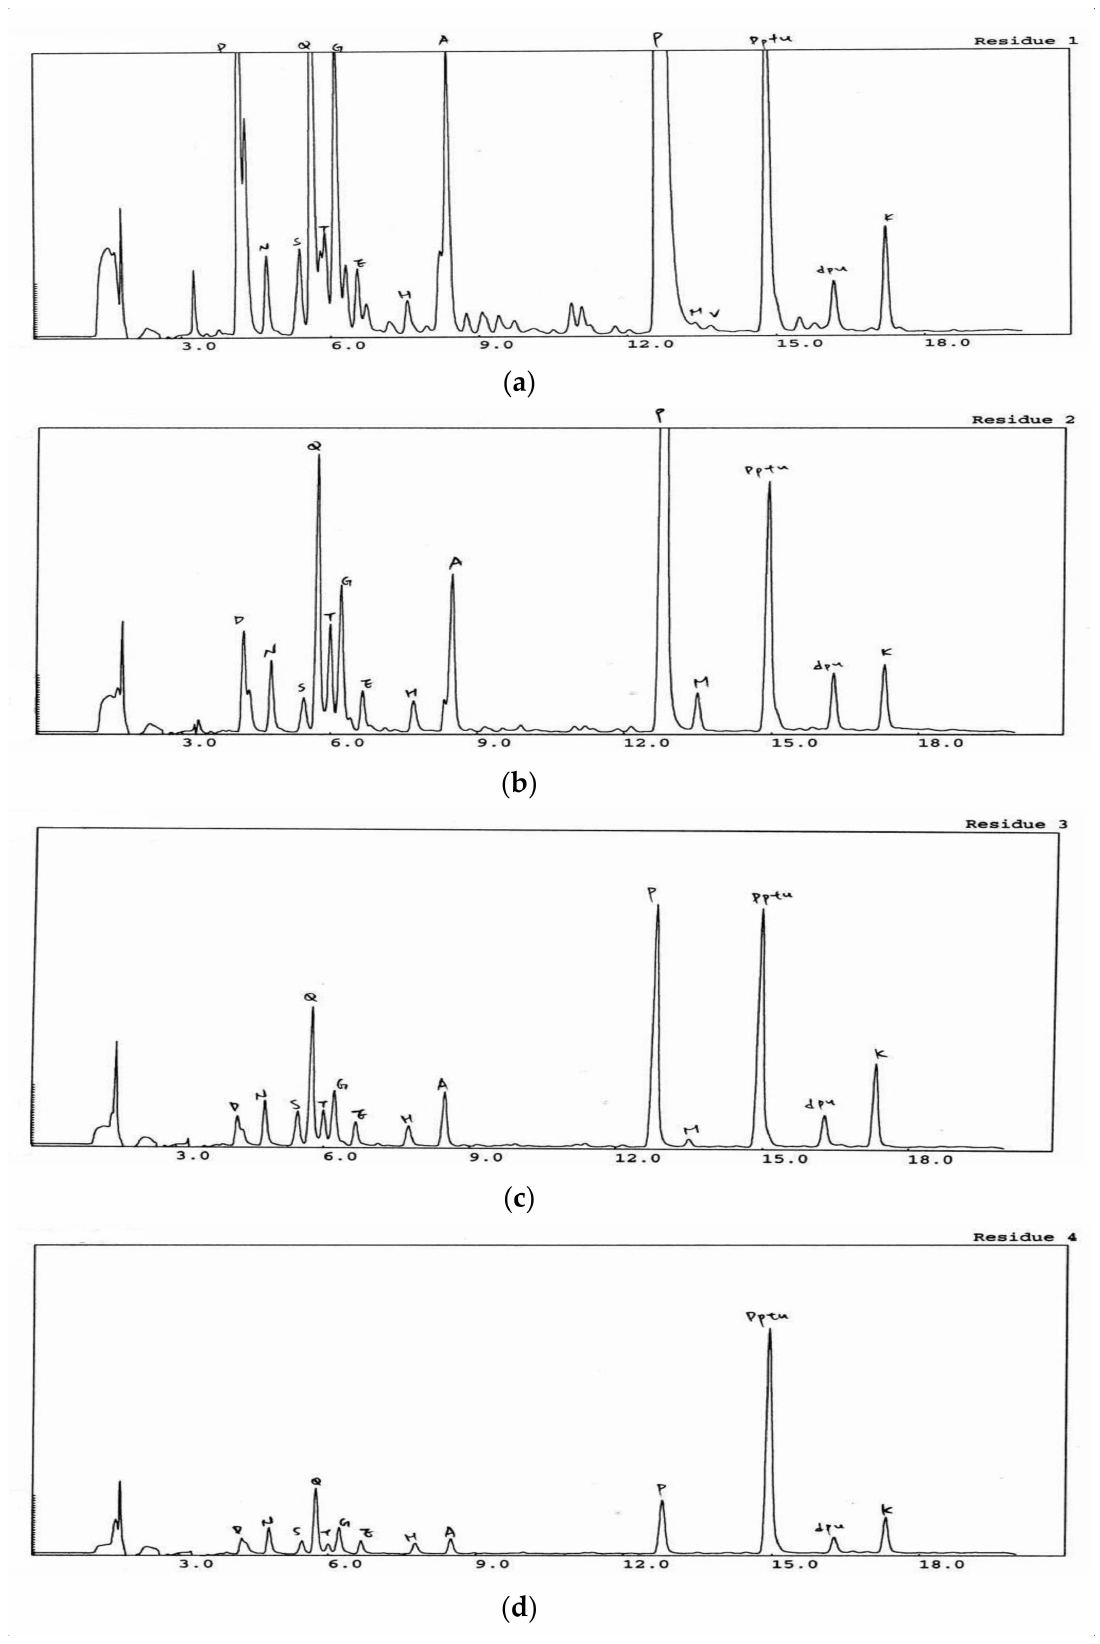
Figure 2. N-terminal sequencing of antioxidant peptides isolated from the water extract of tempeh from Residue 1 ( a ), Residue 2 ( b ), Residue 3 ( c ), and Residue 4 ( d